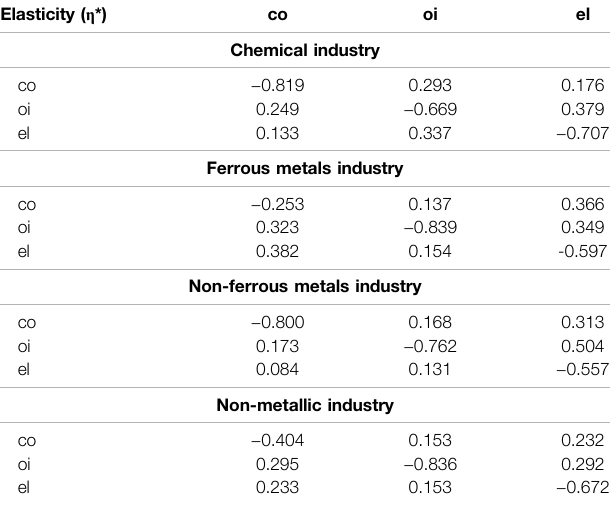
TABLE 3 | The estimating fuel price elasticities in four energy intensive